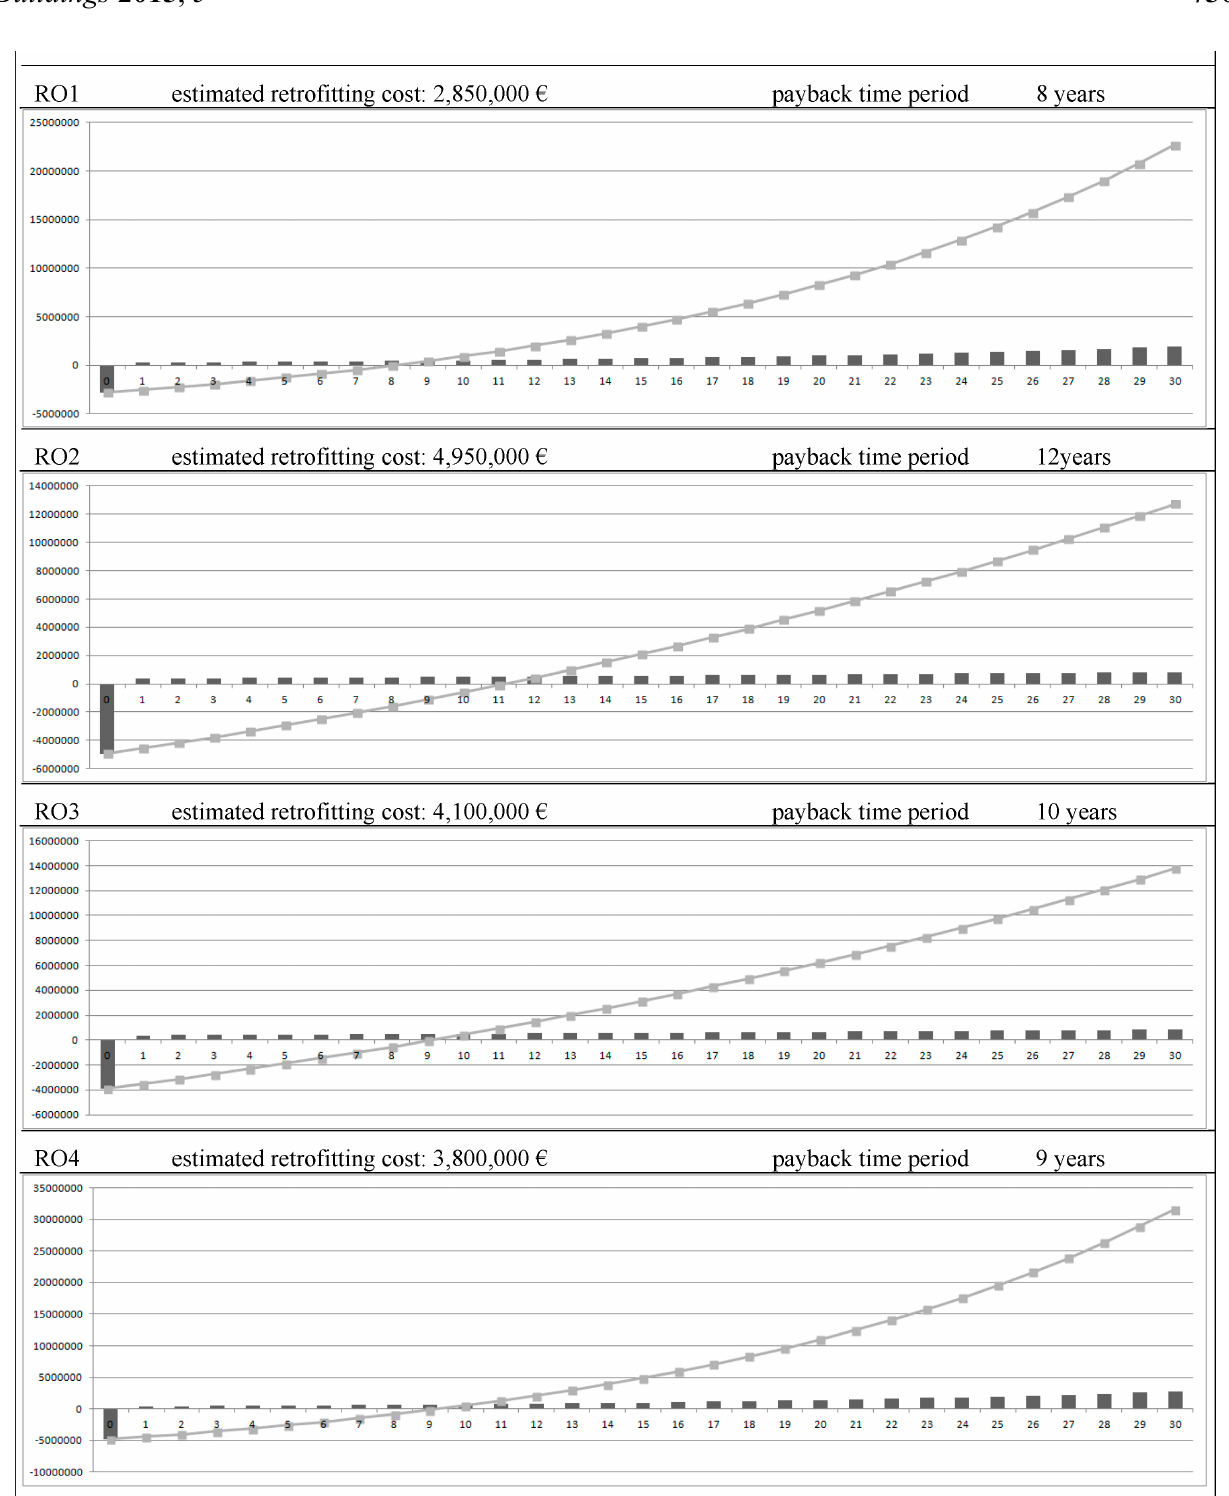
Figure 4. Discounted payback time period of each